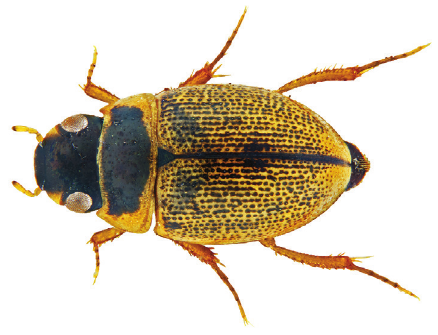
Figure 18. Laccobius uhligi Gentili, 1995 1.8 mm, iSimangaliso Wetland Park, Catalina Bay (site 32), February 2015 DT Bilton, MS Bird & R Perissinotto